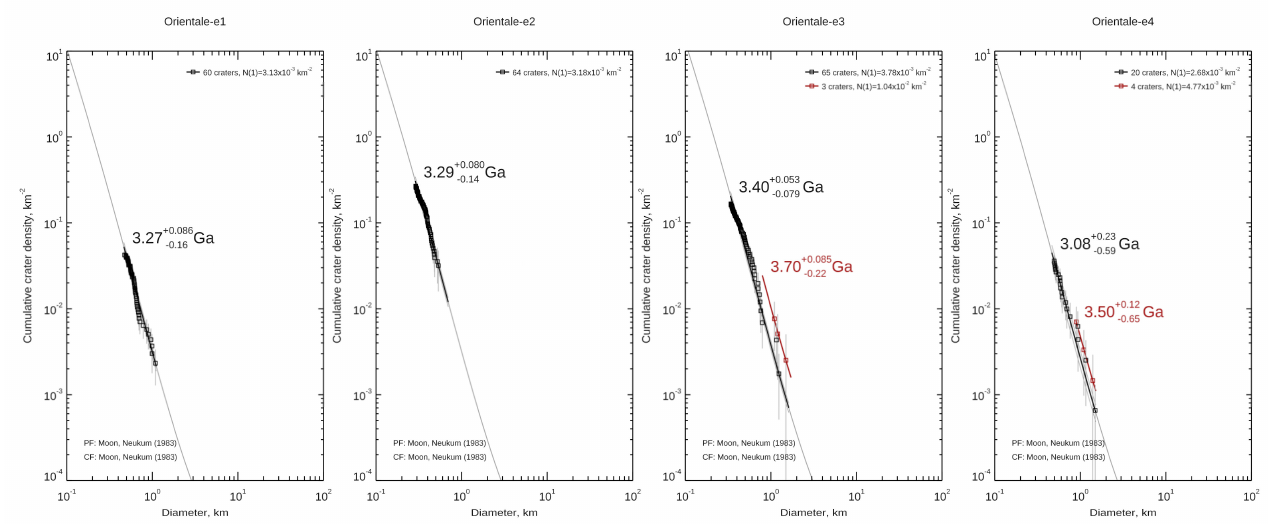
Figure 6. CSFD and mean AMAs of sub-units e1–e4 in Lacus Veris. Black characters denote the surface age of basalts, the red and green colors represent the older age of the underlying basalt. The AMAs were estimated with the Craterstats2 Tool with the production and chronology functions of [37].